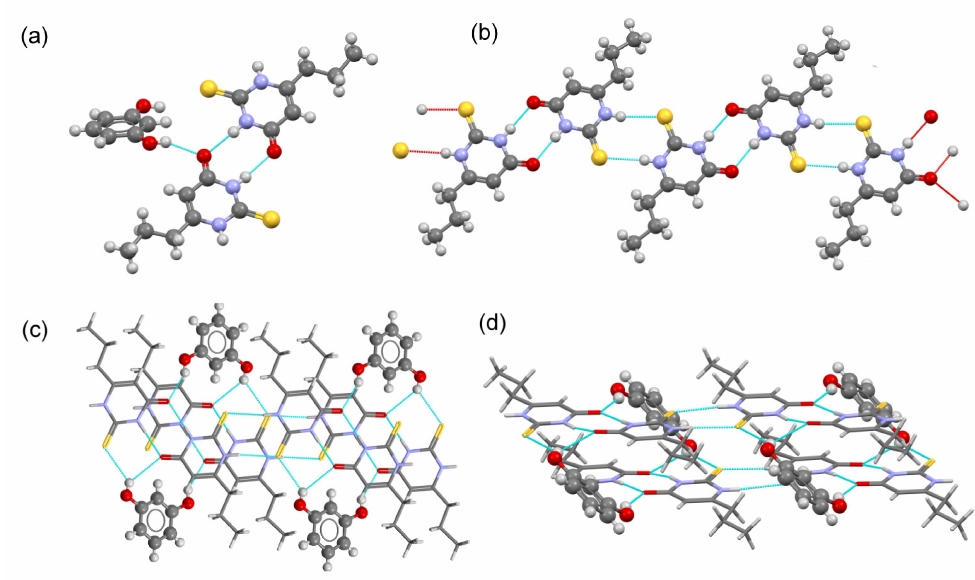
Figure 5. ( a ) Asymmetric unit in cocrystal PTU–RES. ( b ) Detailed view of the PTU chain generated by H-bonding interactions. ( c ) Fragment of a belt-type structure built by connecting two PTU chains through H-bond involving RES molecules. ( d ) Lateral view of the belt-type structure in PTU–RES. PTU–HQ crystallized as a cocrystal in the triclinic P-1 spacegroup. The asymmetric unit consists of one molecule of PTU and half a molecule of HQ located in an